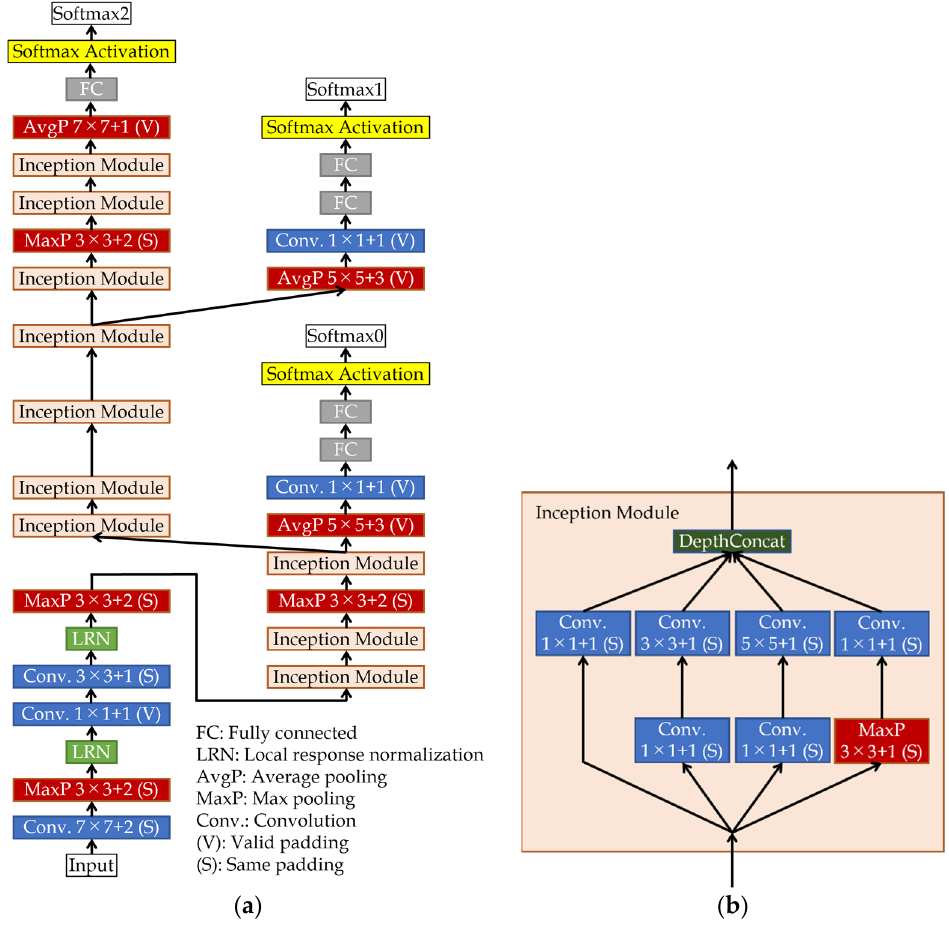
Figure A4. Schema of GoogLeNet architecture [13]: ( a ) overall network; ( b ) inception module where the network is branched to perform dimensionality reduction with a 1 × 1 convolution layer and different size convolution and max pooling.